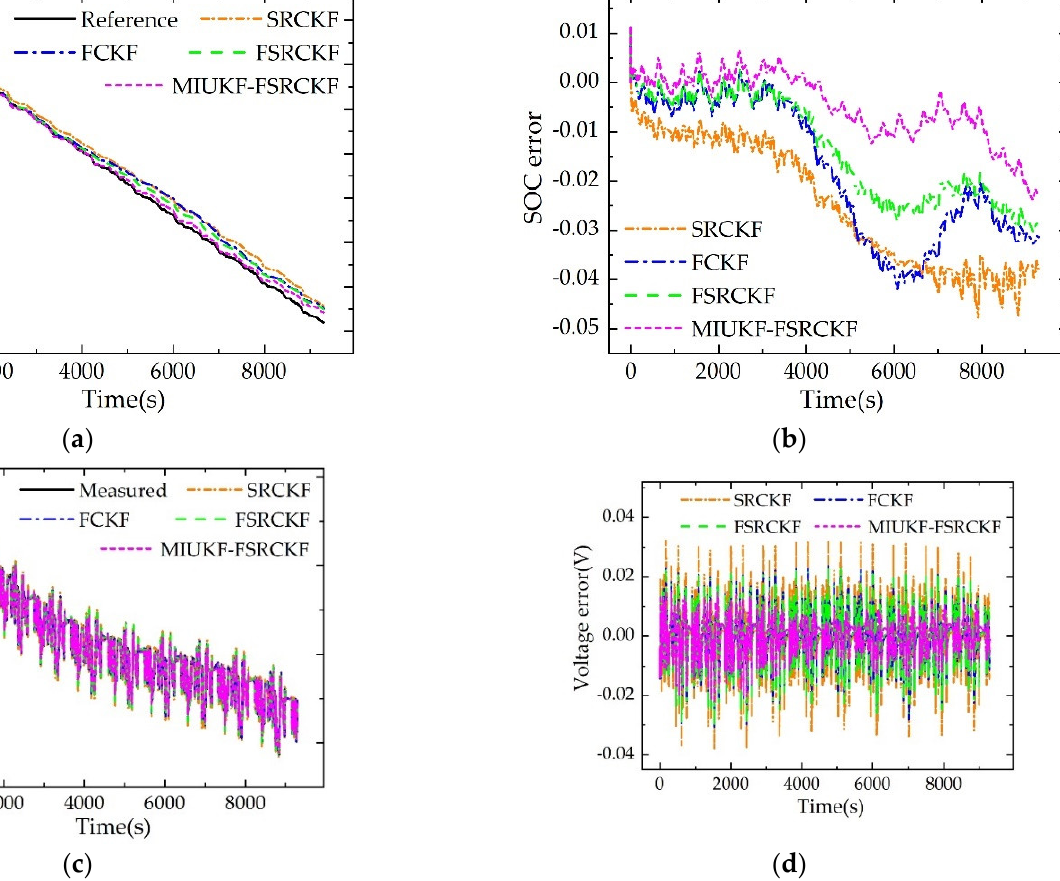
Figure 11. Comparison of the results of the four algorithms under BJDST. The identified R 0 is in-